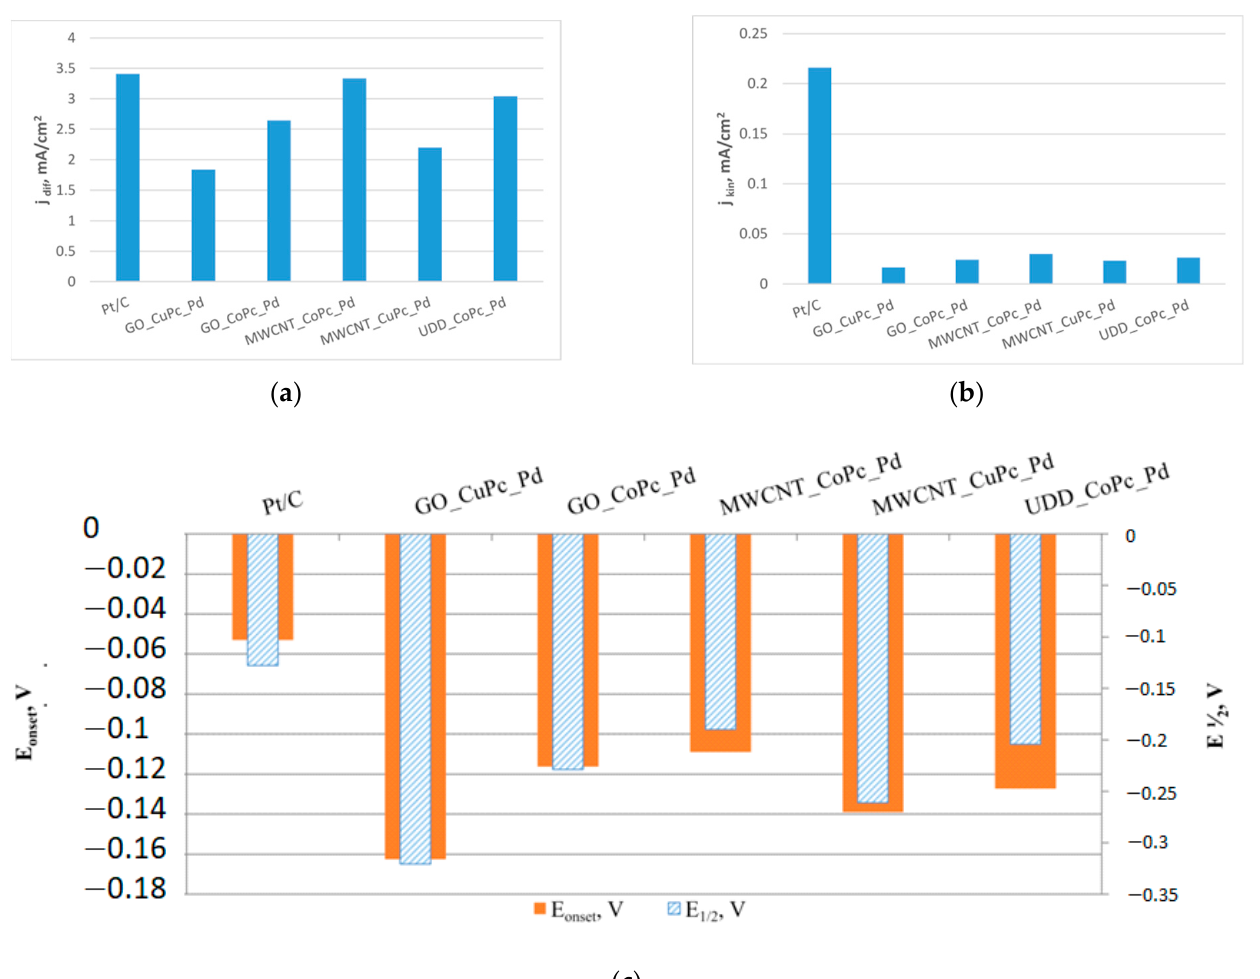
Figure 7. Comparative diagrams for the kinetic and thermodynamic characteristics of the electroreduction of oxygen from an alkaline electrolyte for the synthesized catalysts and a commercial platinum catalyst: ( a ) comparison chart by values j dif ; ( b ) comparison chart by values j kin ; ( c ) comparison chart by values E 1/2 and E onset .